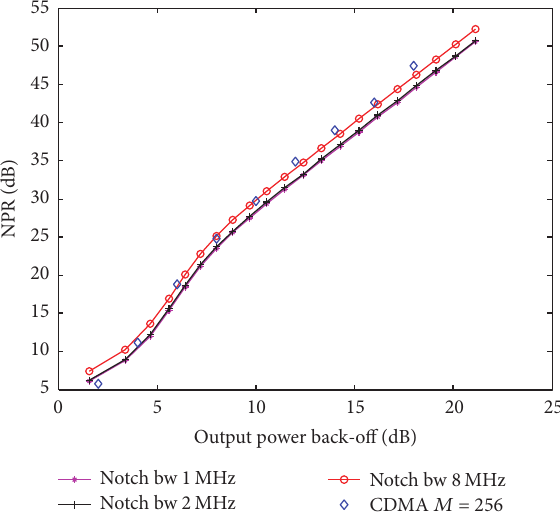
Figure 12: Plot of NPR versus the output power back-off